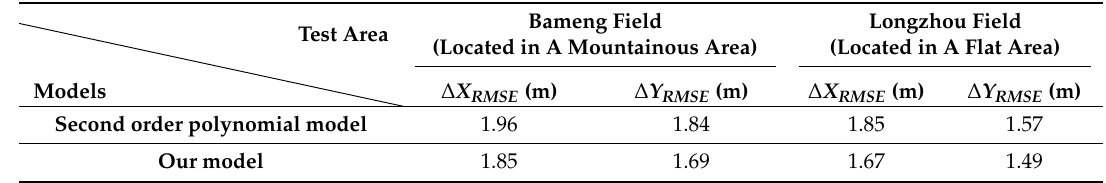
Table 1. Accuracy comparison of mountainous and flat